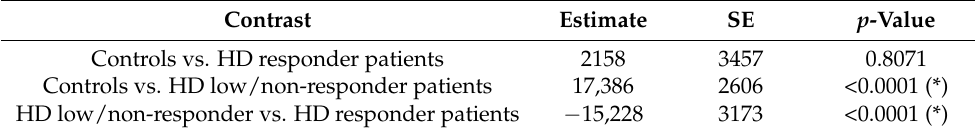
Table 4. Estimated contrasts of the pairwise group comparison of SARS-CoV-2 antibody titres 6–8 weeks after 3D.